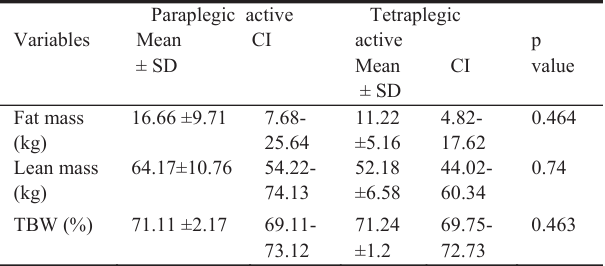
Table 4: BIA results comparing paraplegic active group and tetraplegic active group.